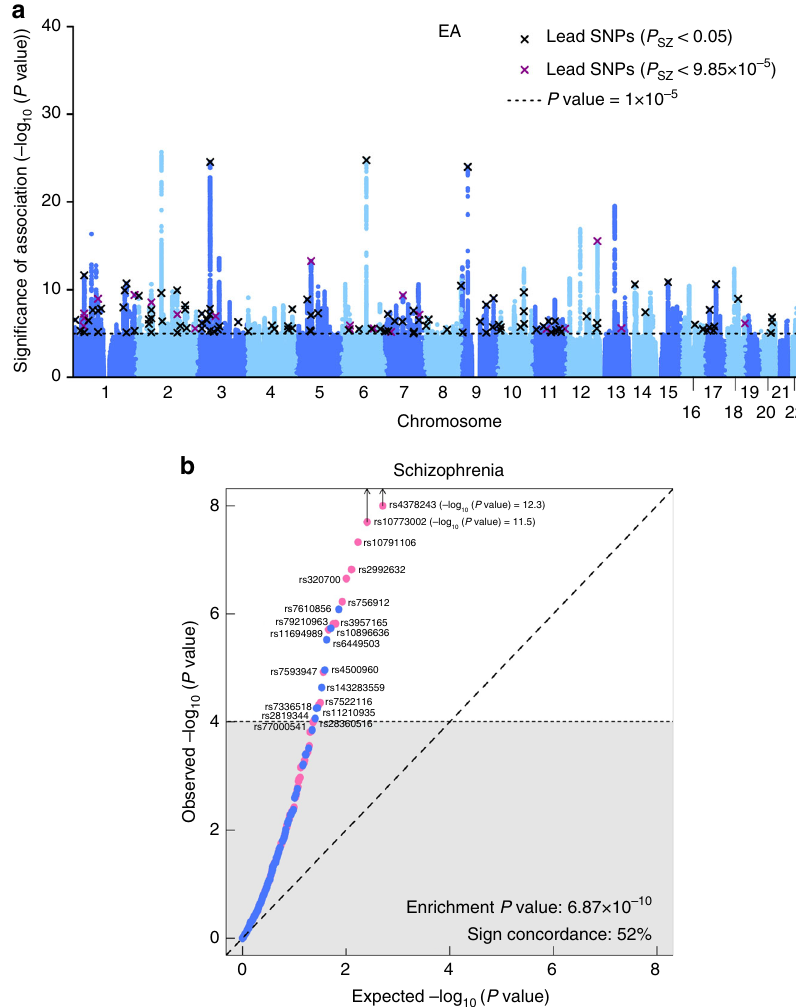
Fig. 2 Results of the proxy-phenotype analyses. Notes: a Manhattan plot for educational attainment (EA) associations ( n = 363,502). The x axis is the chromosomal position, and the y axis is the signi fi cance on a − log 10 scale (two-sided). The black dashed line shows the suggestive signi fi cance level of 10 − 5 that we speci fi ed in our preregistered analysis plan. Black and magenta crosses identify EA-associated lead-SNPs that are also associated with SZ at nominal or Bonferroni-adjusted signi fi cance levels, respectively. b Q – Q plot of the 506 EA-associated SNPs for schizophrenia (SZ) ( n = 34,409 cases and n = 45,670 controls). SNPs with concordant effects on both phenotypes are pink, and SNPs with discordant effects are blue. SNPs outside the grey area (21 SNPs) pass the Bonferroni-corrected signi fi cance threshold that corrects for the total number of SNPs we tested ( P < 0.05/506 = 9.88 × 10 − 5 ) and are labelled with their rs numbers. Observed and expected P values are on a − log 10 scale. For the sign concordance test: P = 0.40,